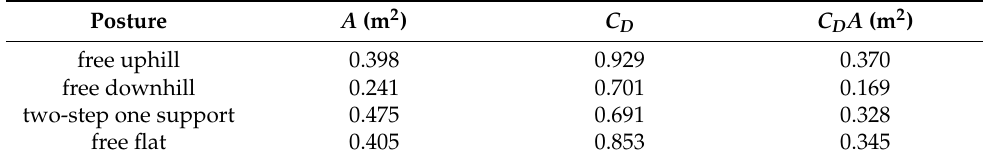
Table 1. Frontal area, drag coefficient, and drag area for the four athletic postures.